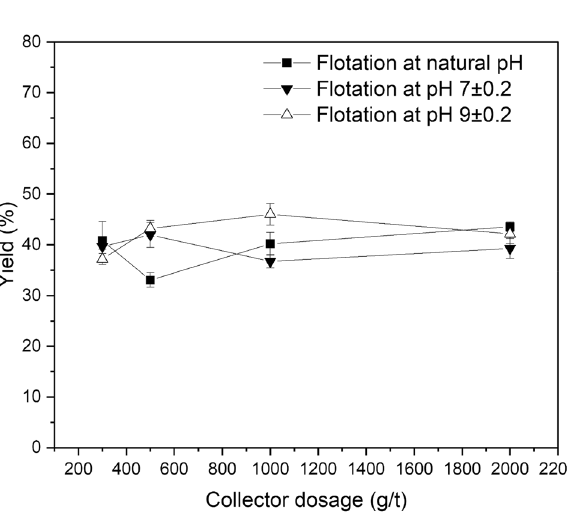
Figure 9. Effect of Collector Dosage on Flotation of Melilite s.s. using decyl dihydrogen